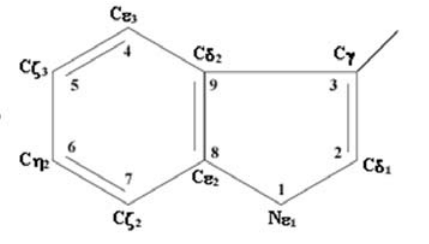
Figure 2. Indole ring of the tryptophan